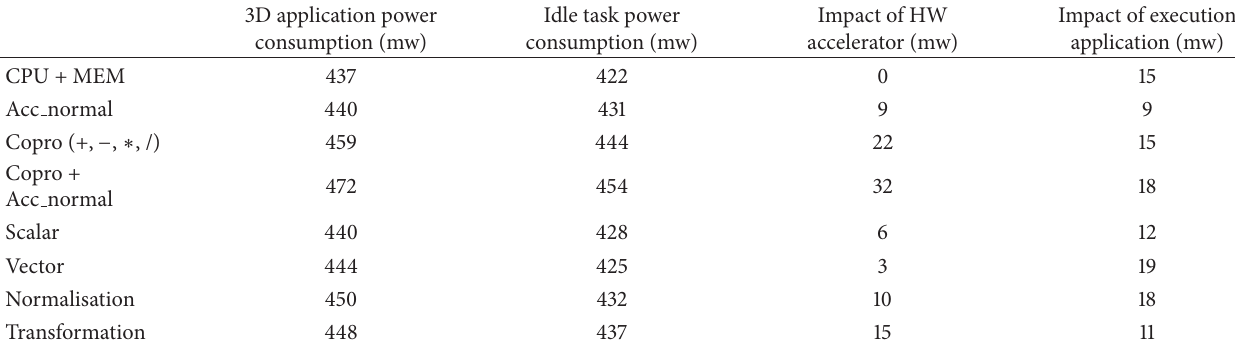
Table 5: Power configuration characterization.